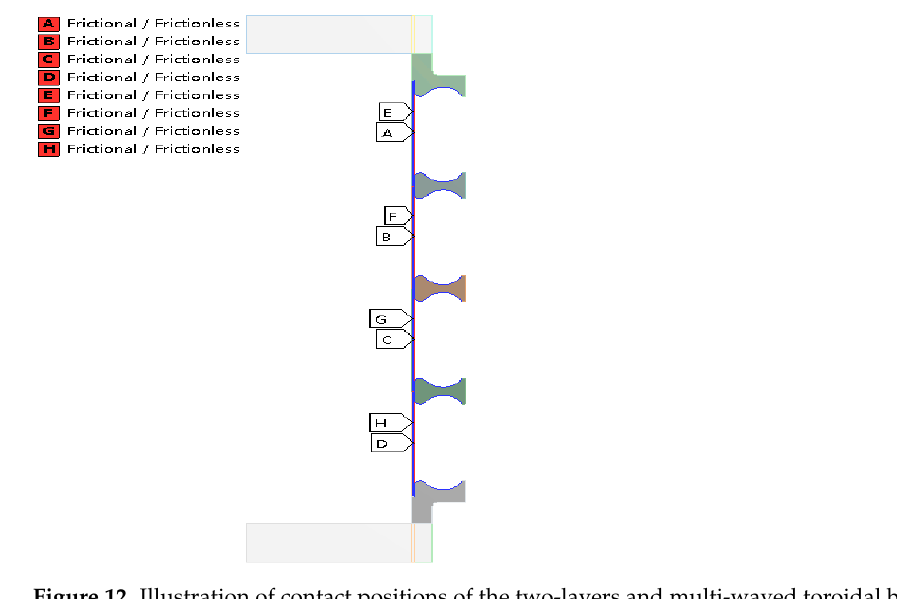
Figure 12. Illustration of contact positions of the two-layers and multi-waved toroidal bellows.